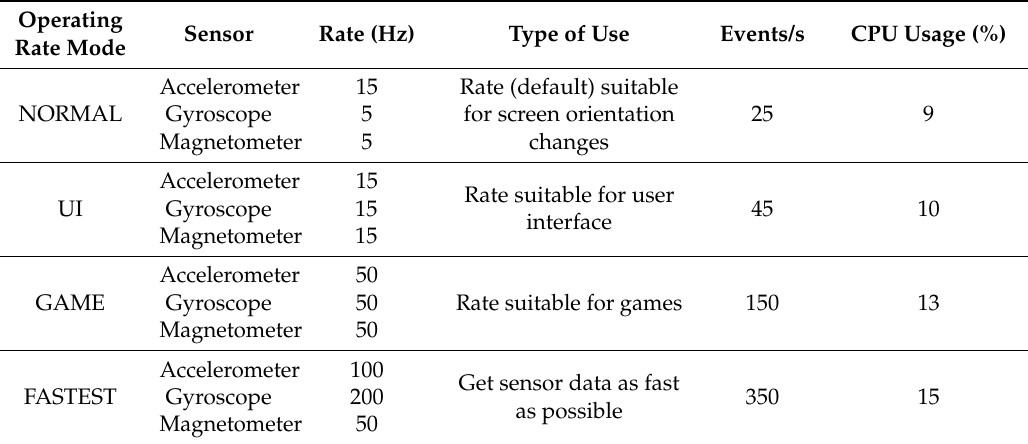
Table 2. Application CPU usage per sensors operating rate